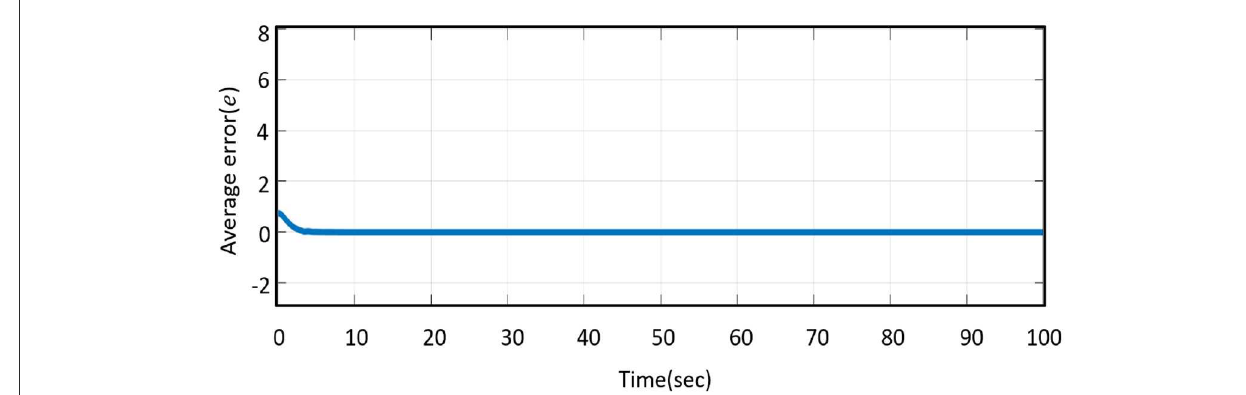
FIGURE12 Average error e.